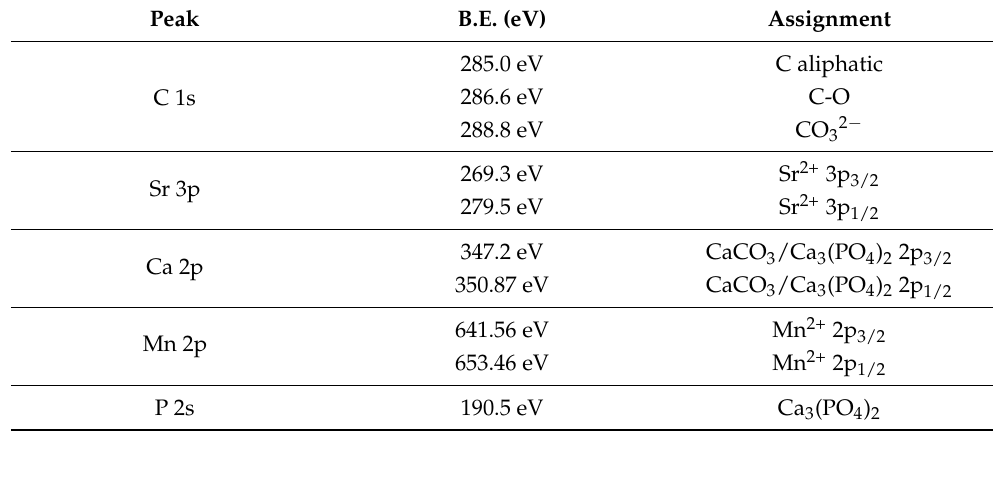
Table 1. XPS analysis results obtained for Mn,Sr-TCP coating.